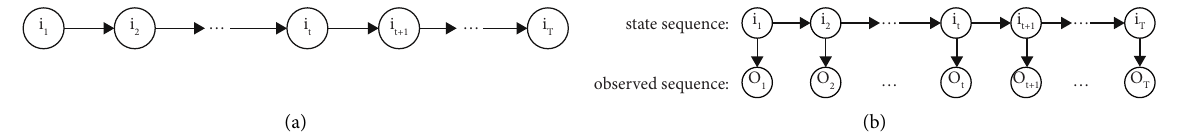
Figure 1: Schematic diagram of Markov process and hidden Markov model